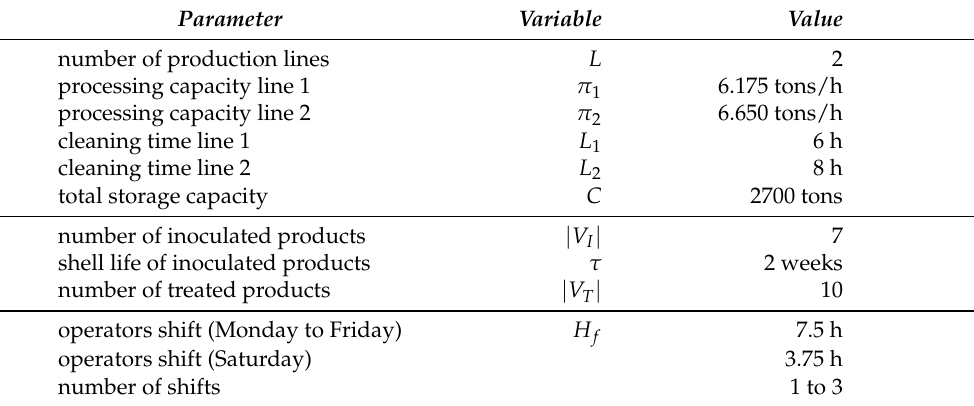
Table 1. Parameters for the considered case